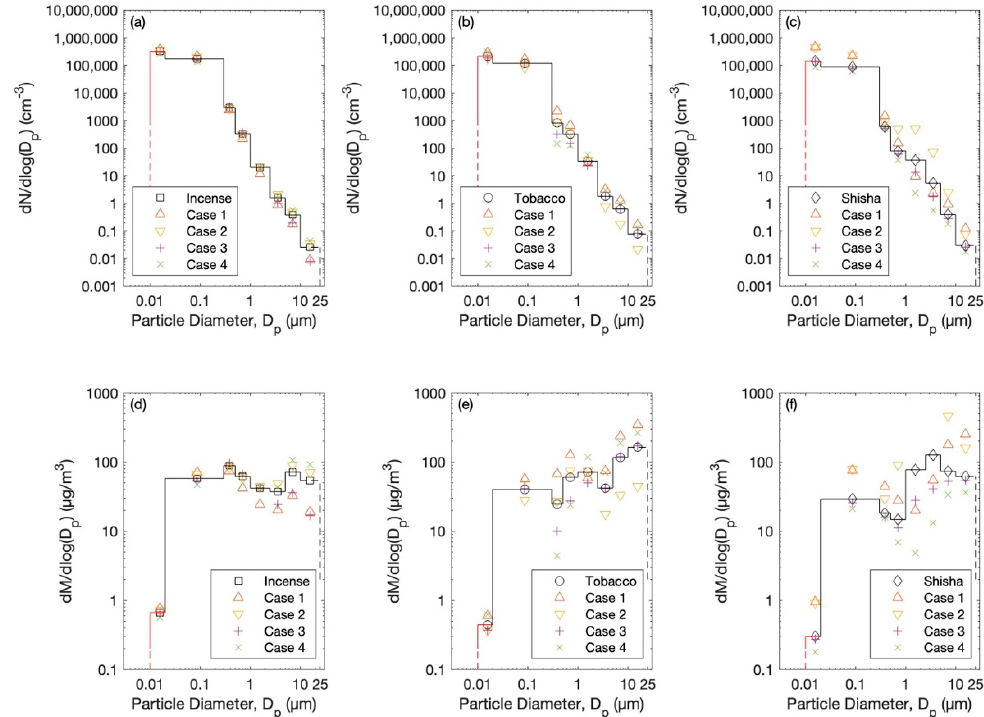
Figure 3. Mean particle number size distributions during each case of the different scenarios: ( a ) incense stick burning, ( b ) cigarette smoking, and ( c ) shisha smoking. ( d – f ) The corresponding mean particle mass size distributions.